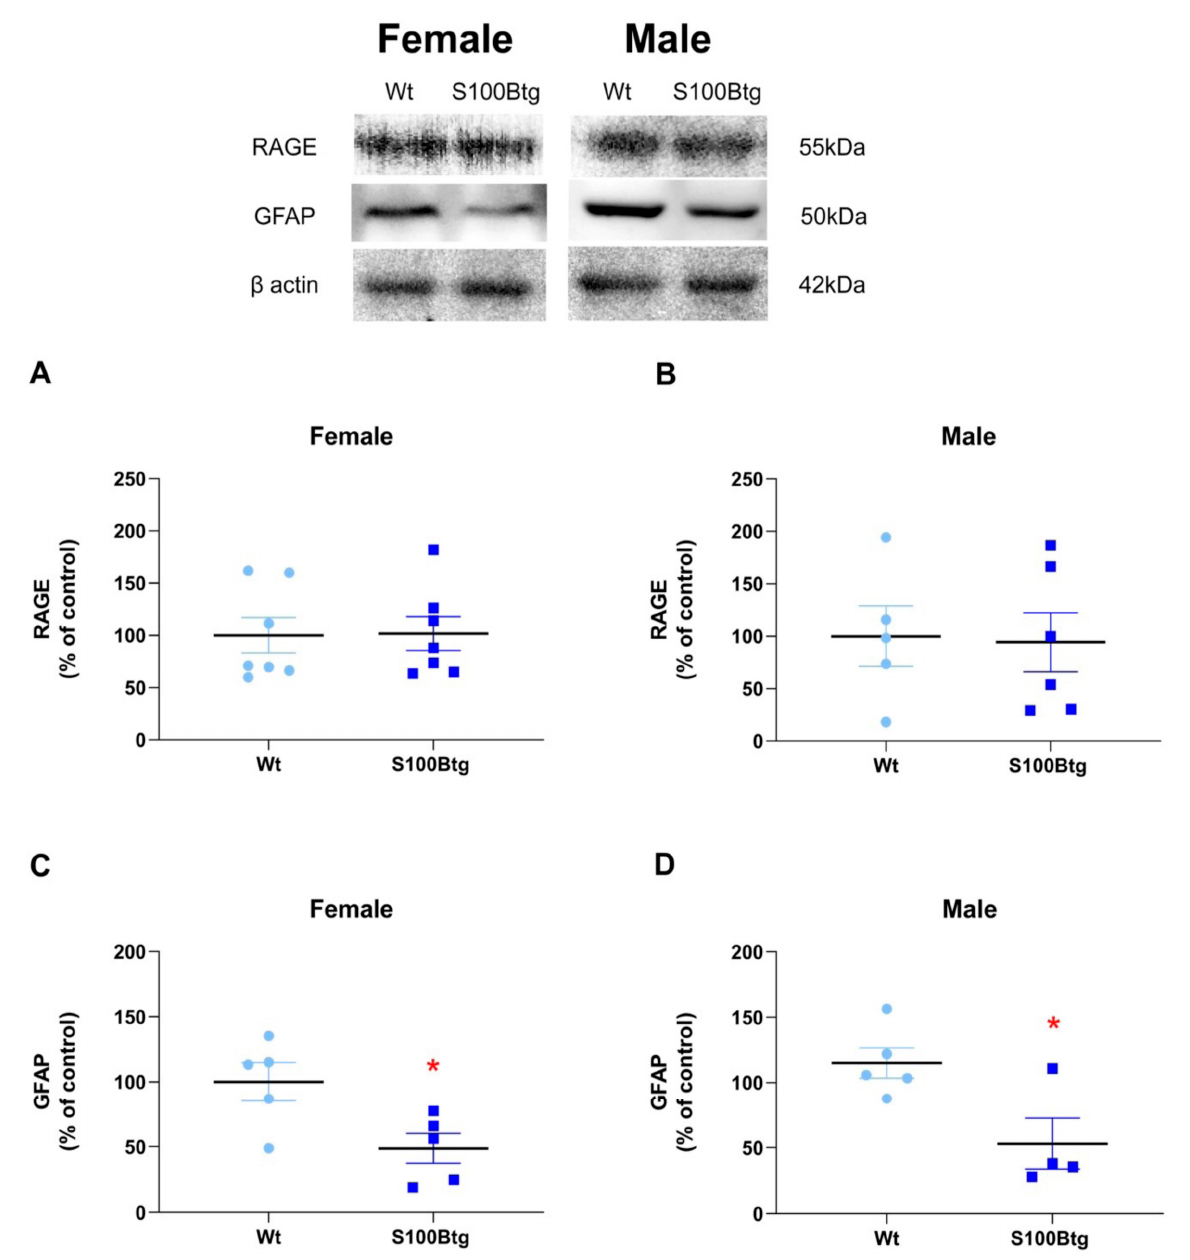
Figure 5. Hippocampal RAGE and GFAP content in one-year-old S100Btg and wt mice. ( A , B ) RAGE, and ( C , D ) GFAP; analyzed by Western blotting, and protein bands quantified by densitometry. Data are expressed as means ± SE (7 mice/group). * Indicates a statistically significant difference (Student’s t -test, assuming p < 0.05).